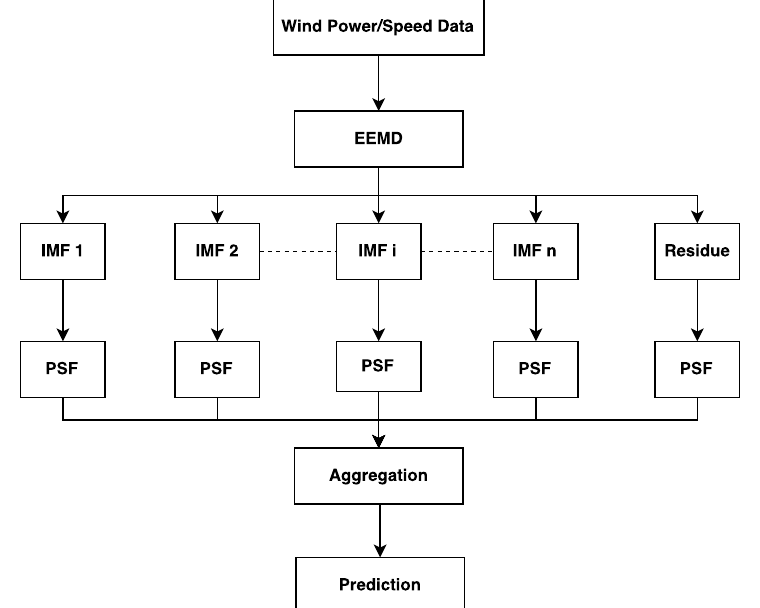
Figure 2. The procedure of EEMD-PSF